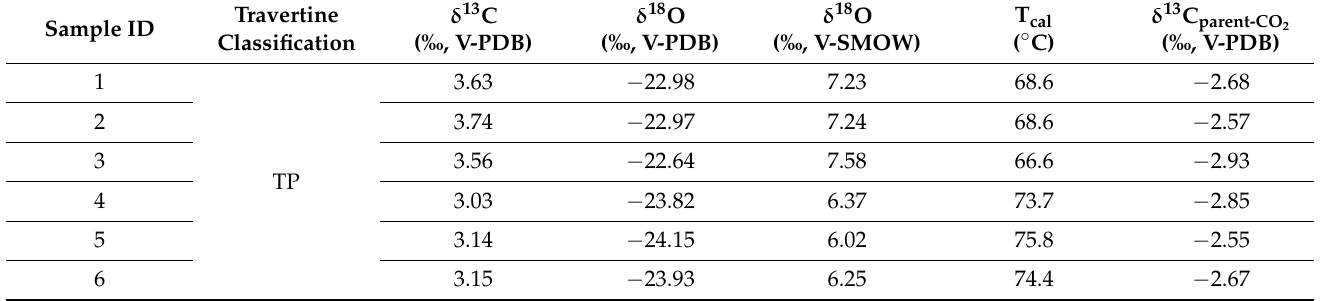
Table 2. δ 13 C, δ 18 O, calculated paleo-temperature (T cal ), δ 13 C parent CO recently formed travertines. The depositional paleo-temperature ( ◦ C) of the travertines was